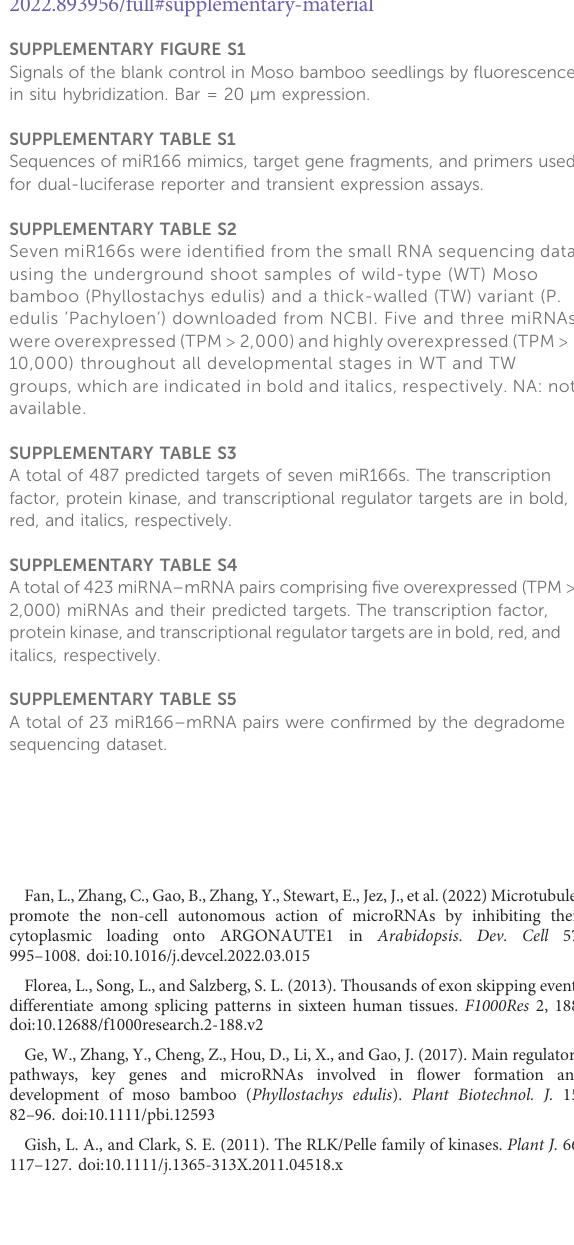
SUPPLEMENTARY FIGURE S1 Signals of the blank control in Moso bamboo seedlings by fl uorescence in situ hybridization. Bar = 20 µm expression. SUPPLEMENTARY TABLE S1 Sequences of miR166 mimics, target gene fragments, and primers used for dual-luciferase reporter and transient expression